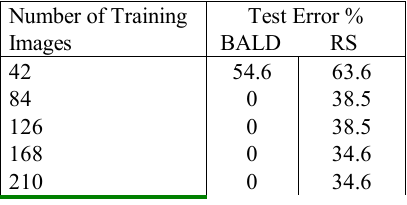
Table 2 . Georgioupoli “Scene 1”: Test errors as resulting from the different acquisition functions a) Bayesian active learning disagreement and b) Random sampling, for the various amounts of training images.